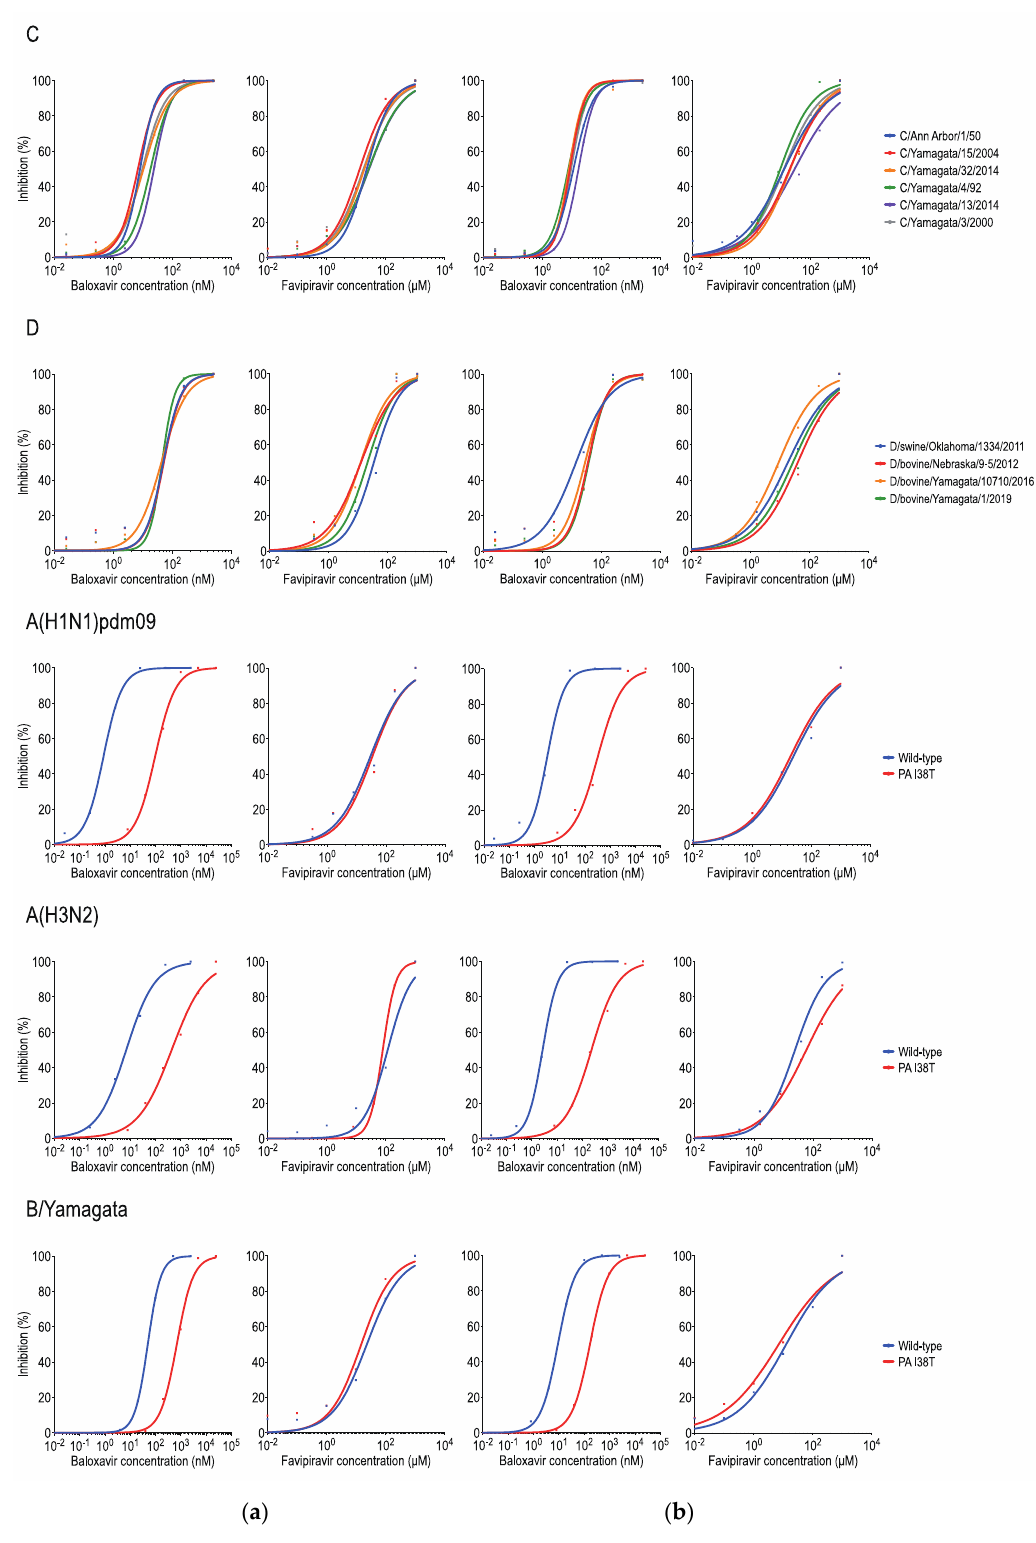
Figure 1. Antiviral activity of RNA polymerase inhibitors against influenza C and D viruses. Baloxavir and favipiravir susceptibilities were determined by using a focus reduction assay in MDCK cells ( a ) and ST cells ( b ). The 50% inhibitory concentration (IC 50 ) values for each drug are presented in Table 1. C: influenza C virus; D: influenza D virus; A(H1N1)pdm09: influenza A(H1N1)pdm09